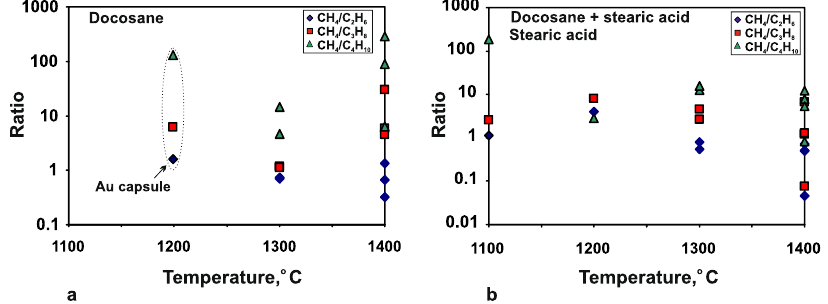
Figure 4. Normalised peak area ratios of CH 4 /C 2 H 6 , CH 4 /C 3 H 8 and CH 4 /C 4 H 10 as a function of temperature, according to GC-MS analysis of quenched fluids synthesised at 6.3 GPa from different starting compositions: a = docosane; b = docosane + stearic acid mixture and stearic